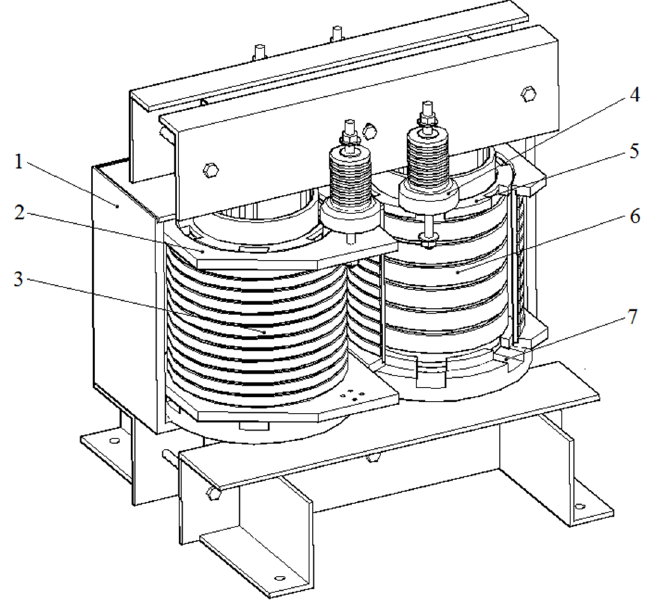
Figure 10. Construction of a 13.8 kVA superconducting transformer, 1—cryostat, 2—primary winding carcass, 3—primary winding HV, 4—current bushings, 5—secondary winding carcass, 6—secondary winding LV, 7—channels cooling.